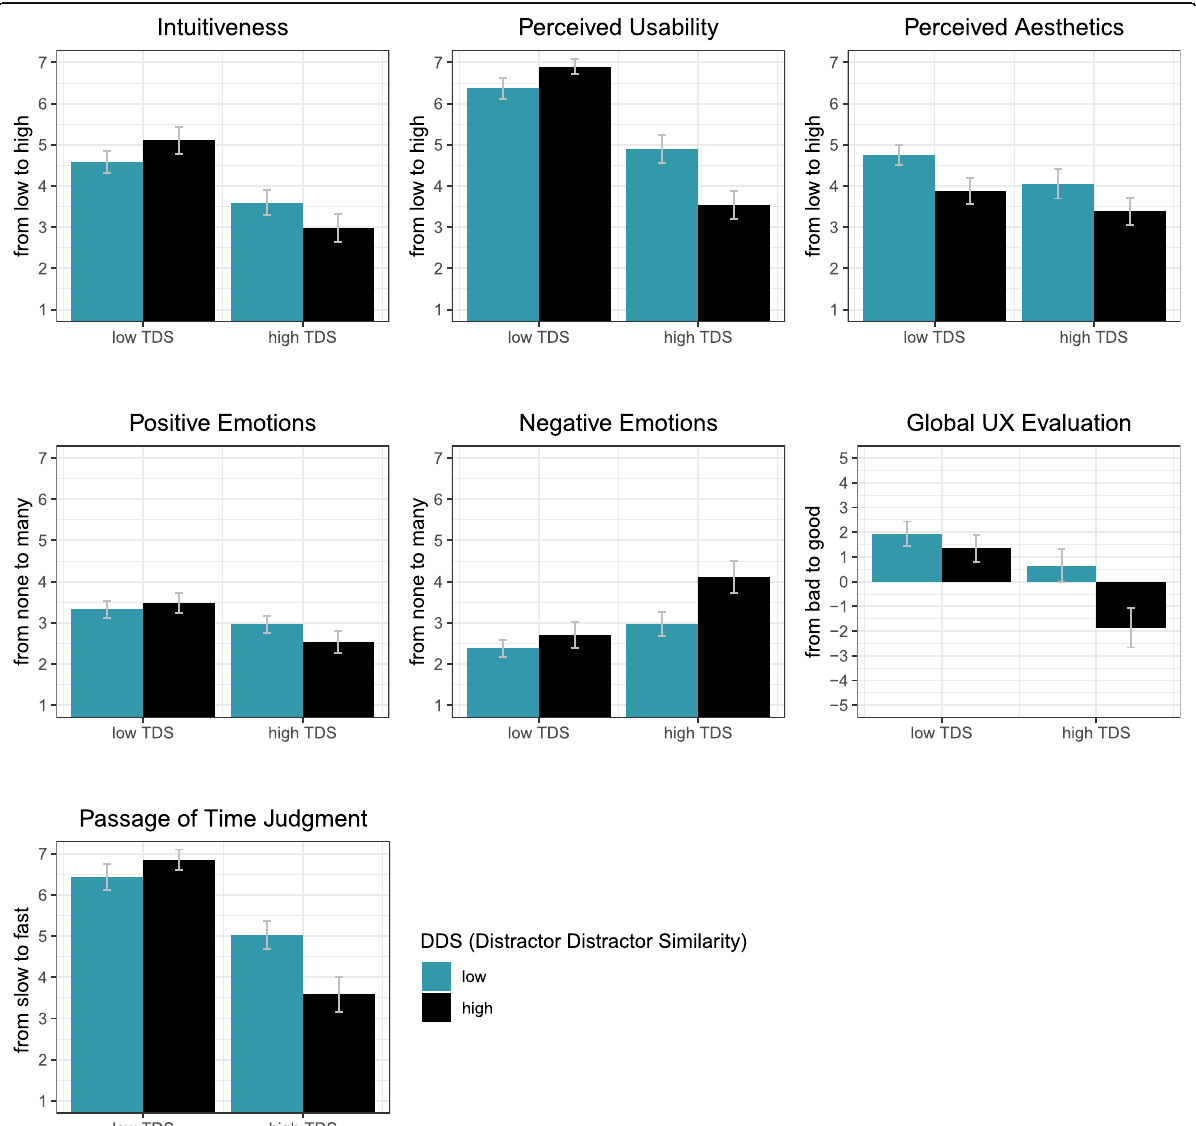
Fig. 5 Bar graphs of the seven rating dimensions: intuitiveness, perceived usability, perceived aesthetics, emotions, global UX evaluation, and passage of time judgments. On the y-axis , we present the range of the scales. The first adjective (from … ) stands for low values and the second adjective (to … ) stands for high